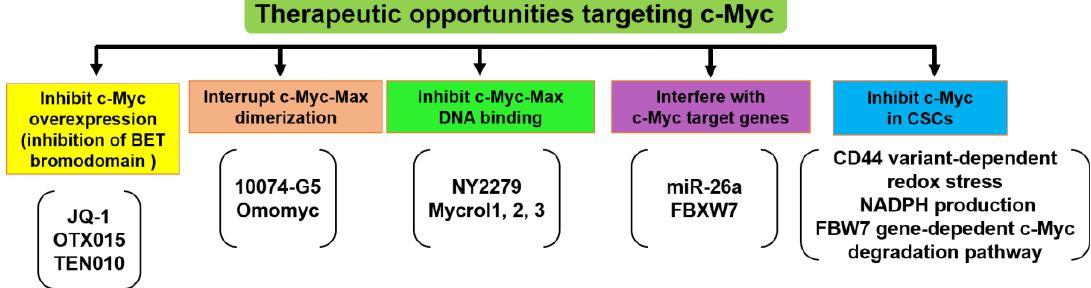
Figure 6. Strategies for targeting c-Myc. Several therapeutic agents were developed to inhibit c-Myc by different mechanisms. These include inhibitors that block Myc expression, including bromodomain and extra-terminal domain (BET) bromodomain inhibitors such as JQ-1, OTX015, and TEN010. Other inhibitors reduce c-Myc stability and functions by interfering with c-Myc-Max interaction (10074-G5 and omomyc) or inhibit its binding with DNA (NY2279 and Mycrol1, 2, 3). Some inhibitors interfere with c-Myc target genes such as miR-26a and F-box and WD repeat domain-containing (FBXW)7. In CSCs, inhibition of c-Myc-dependent metabolic reprogramming through CD44 variant-dependent redox stress, nicotinamide adenine dinucleotide phosphate hydrogenase (NADPH) production via decreasing glutaminolysis, or FBW7 gene-dependent c-Myc degradation pathway is regarded as a promising strategy.